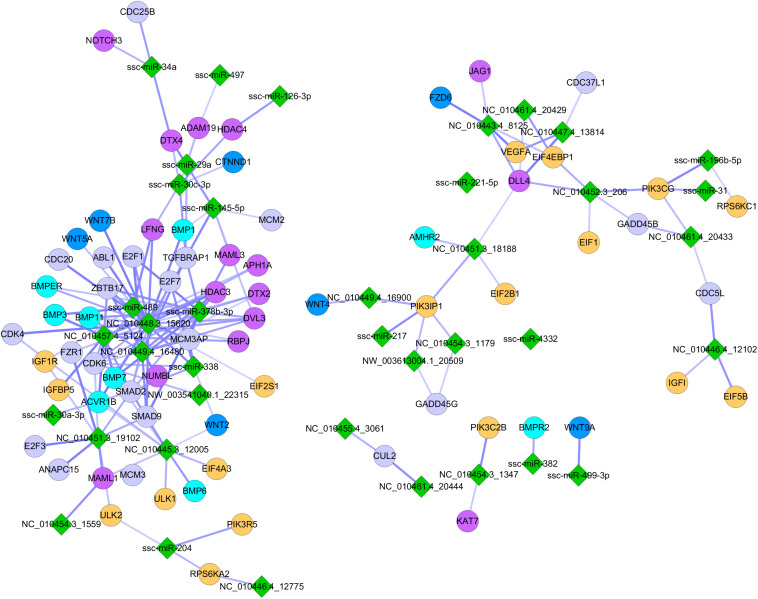
Influence of MCR on critical signaling pathways involved in embryonic myogenesis. Green diamonds indicate DE miRNAs identified between NE and RE group; Dots with different colors indicate miRNA targeted genes involving in different myogenic signaling pathways (gray: MAPK signaling pathway; yellow: mTOR signaling pathway; purple red: Notch signaling pathway; navy blue: WNT signaling pathway; wathet blue: BMP signaling pathway).